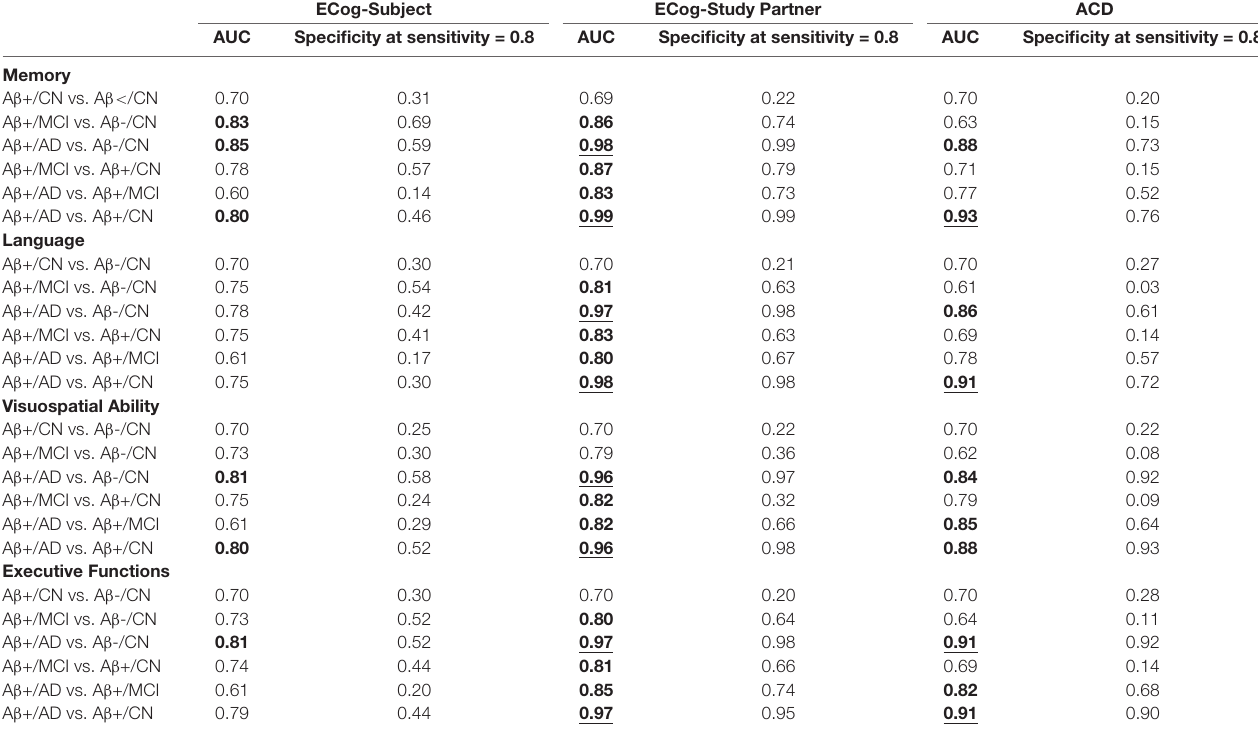
TABLE 3 | Results of ROC/AUC analysis. ECog-Subject ECog-Study Partner ACD AUC Specificity at sensitivity = 0.8 AUC Specificity at sensitivity = 0.8 AUC Specificity at sensitivity =